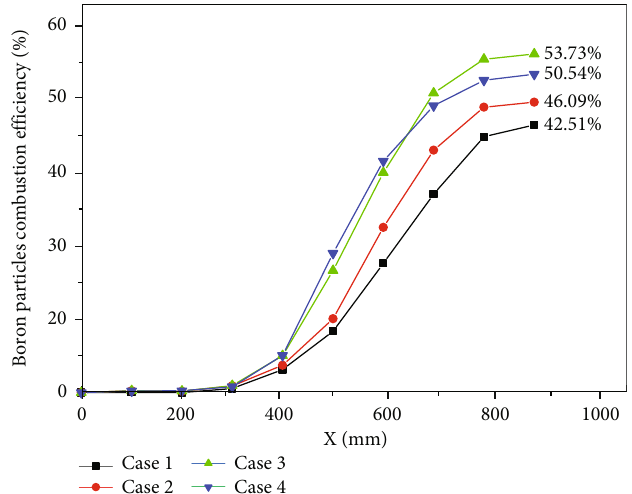
Figure 13: Boron particle combustion e ffi ciency in each cross section of afterburners.